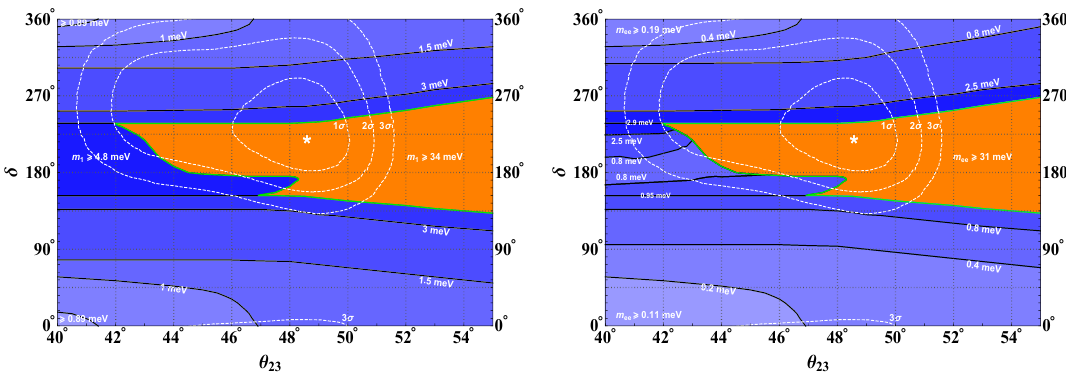
Figure 2 . Isocontour lines for the lower bound on the lightest neutrino mass m 1 (left panel) and on the 0 (cid:23)(cid:12)(cid:12) e(cid:11)ective neutrino mass m ee (right panel) for (cid:11) 2 = 5 in the plane (cid:14) versus (cid:18) 23 . The white dashed lines are the current experimentally favoured regions for (cid:14) and (cid:18) 23 at the indicated C.L. from global analyses [22] and the white stars indicate the best (cid:12)t values. The blue area indicates (cid:28) A solutions, while the orange area indicates (cid:28) B